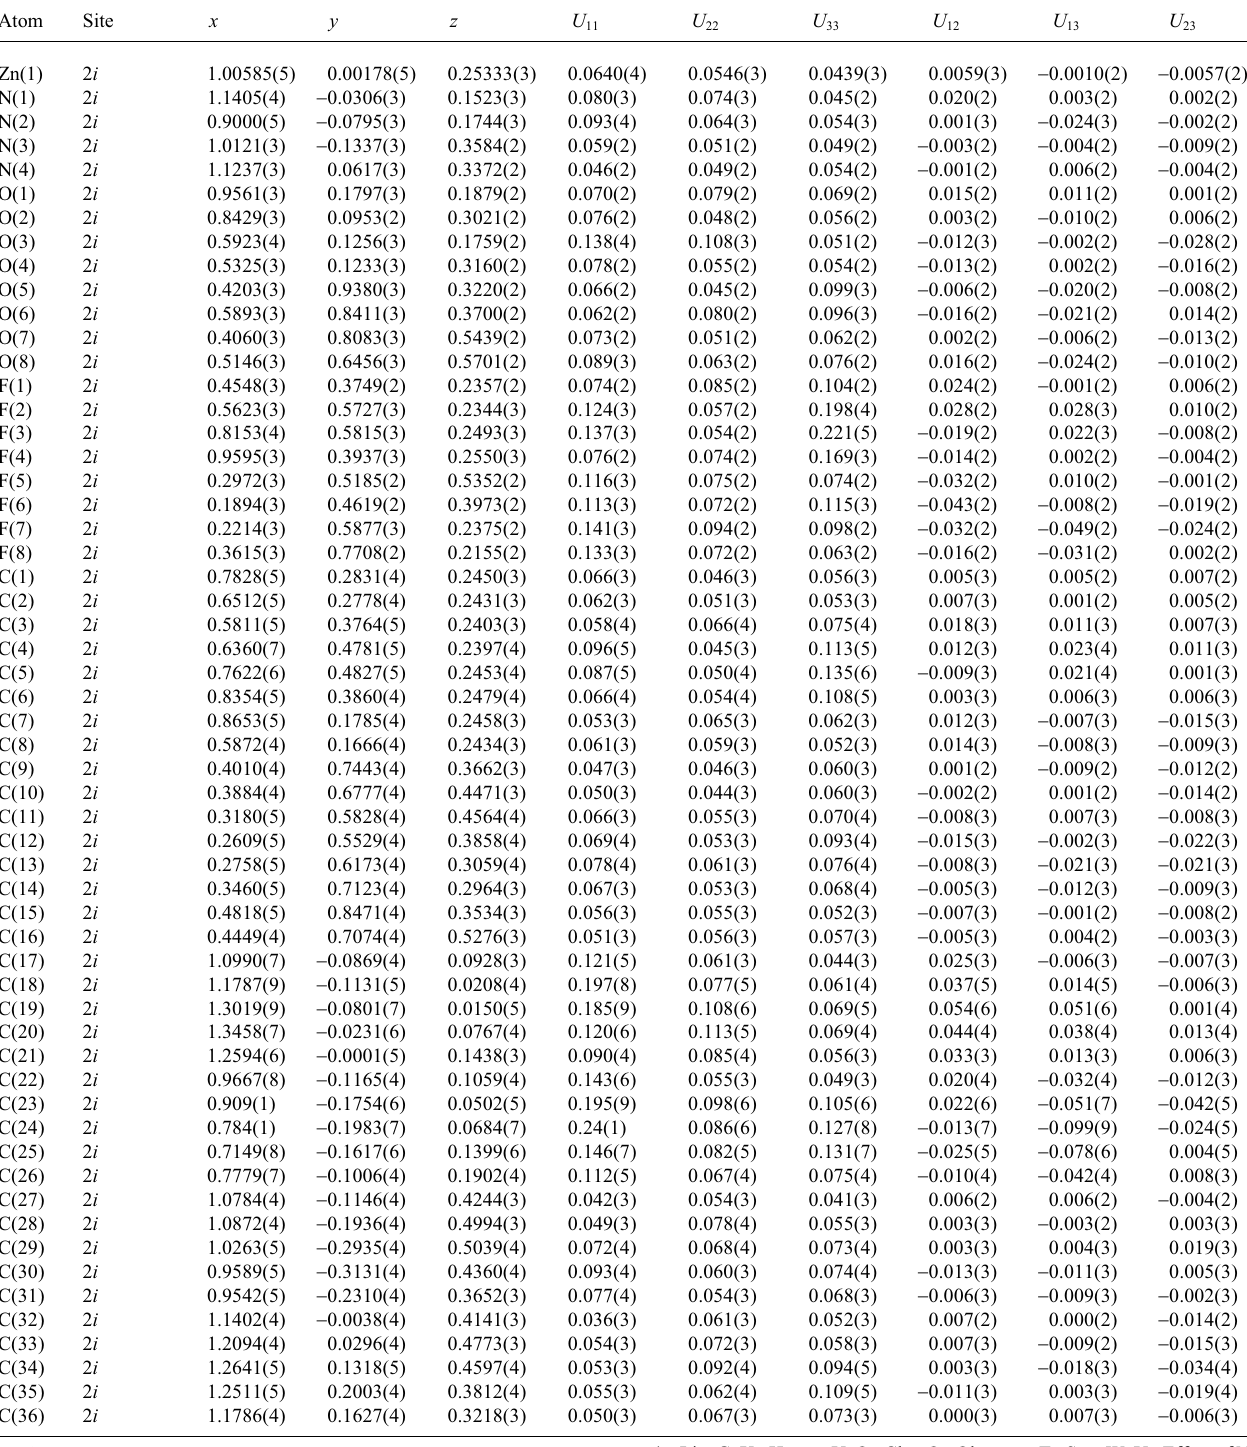
Table 3. Atomic coordinates and displacement parameters (in Å 2 )